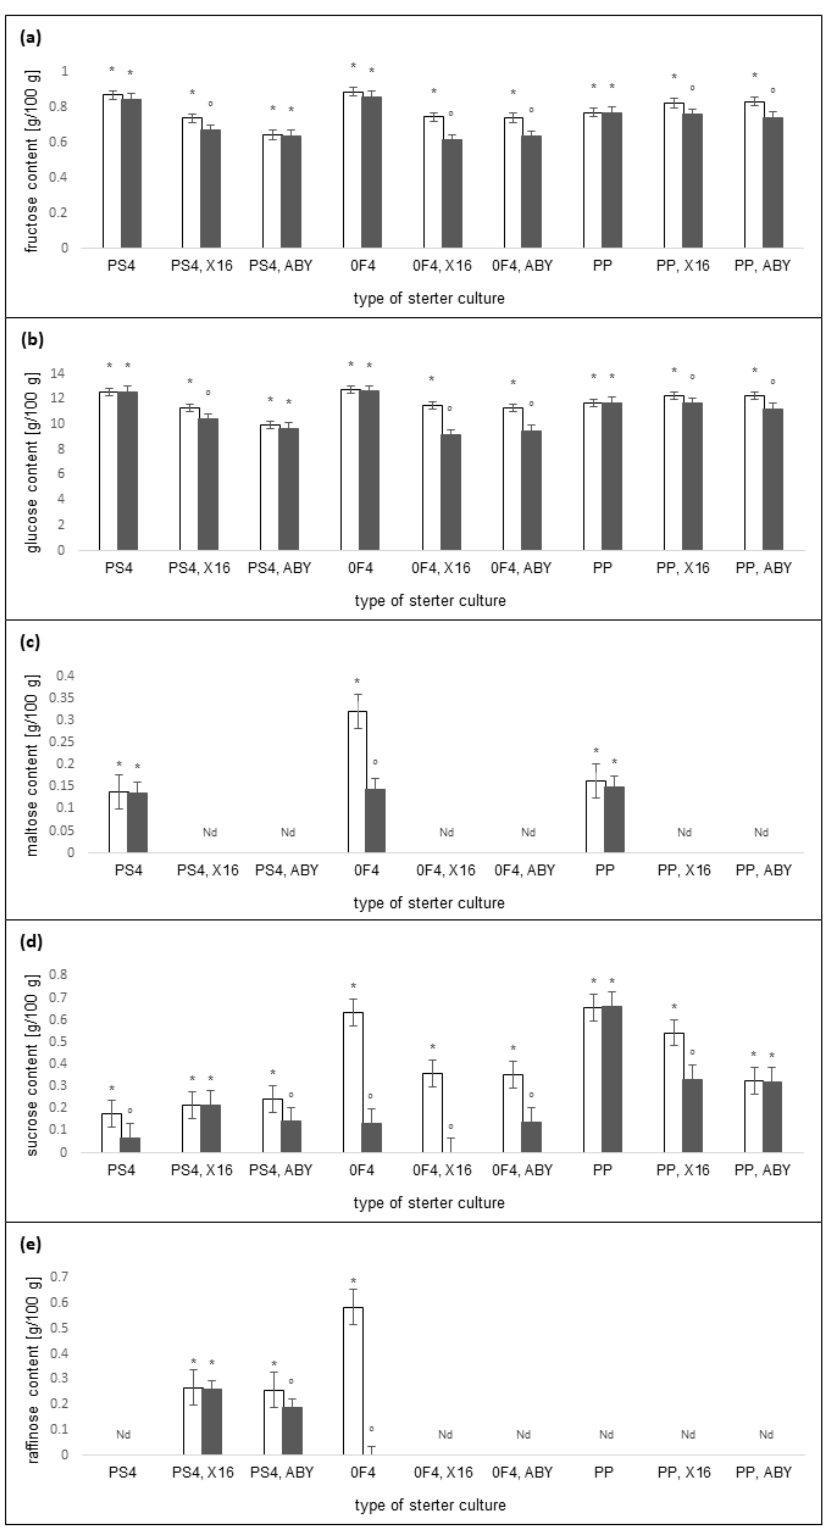
Figure 4. The changes in the ( a ) fructose, ( b ) glucose, ( c ) maltose, ( d ), sucrose, and ( e ) raffinose content in rice-based beverages after 14 days of storage (white column), and after 28 days of storage (dark grey column) when inoculated with different starter cultures. Within each starter culture, the group means with a common symbol are not significantly different ( p ≥ 0.05). Error bars represent standard error of the mean. Nd—not